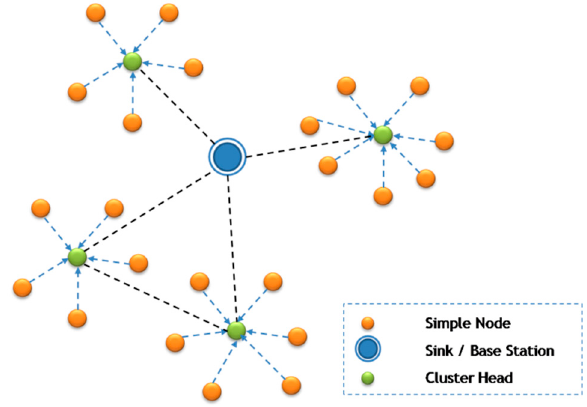
Figure 3. Hierarchical routing model .